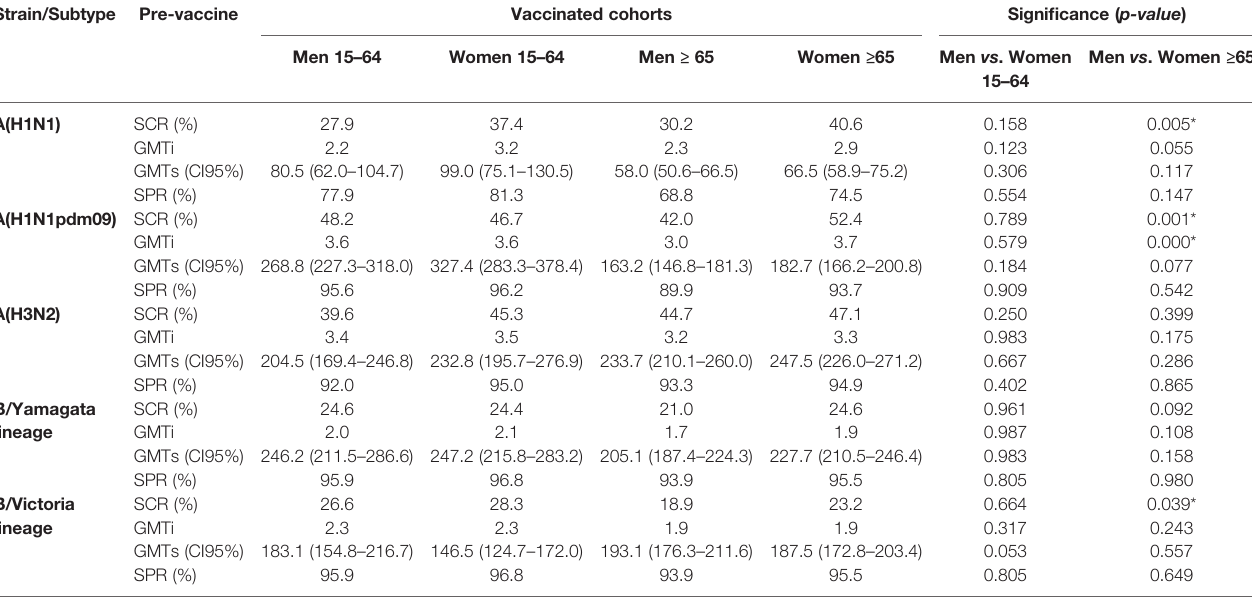
P-values of the comparison between both genders for each age group. Signi fi cant differences (p<0.05) are marked with *.